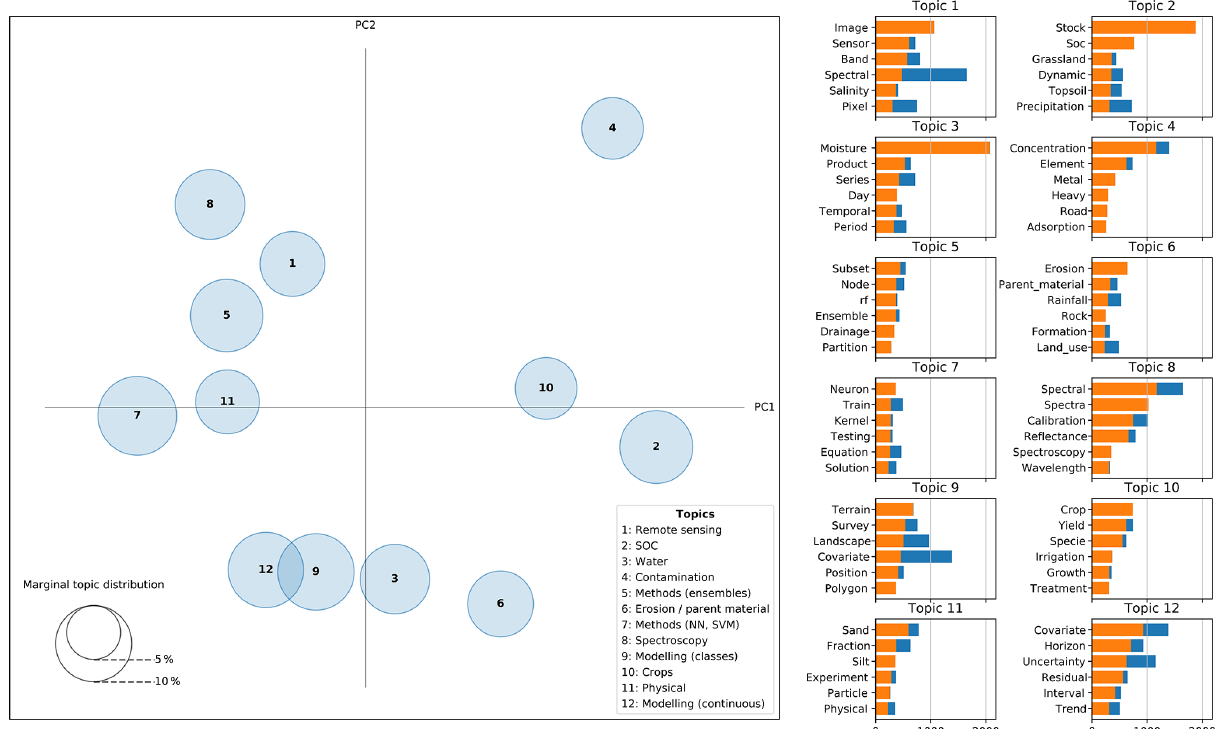
Figure 9. Inter-topic distance map. Dimension reduction via Jensen–Shannon divergence (Lin, 1991) and principal coordinate analysis. Top- 6 more relevant words per topic. Complete bars (blue + orange) correspond to overall term frequency and shaded bars (orange) correspond to term frequency within the selected